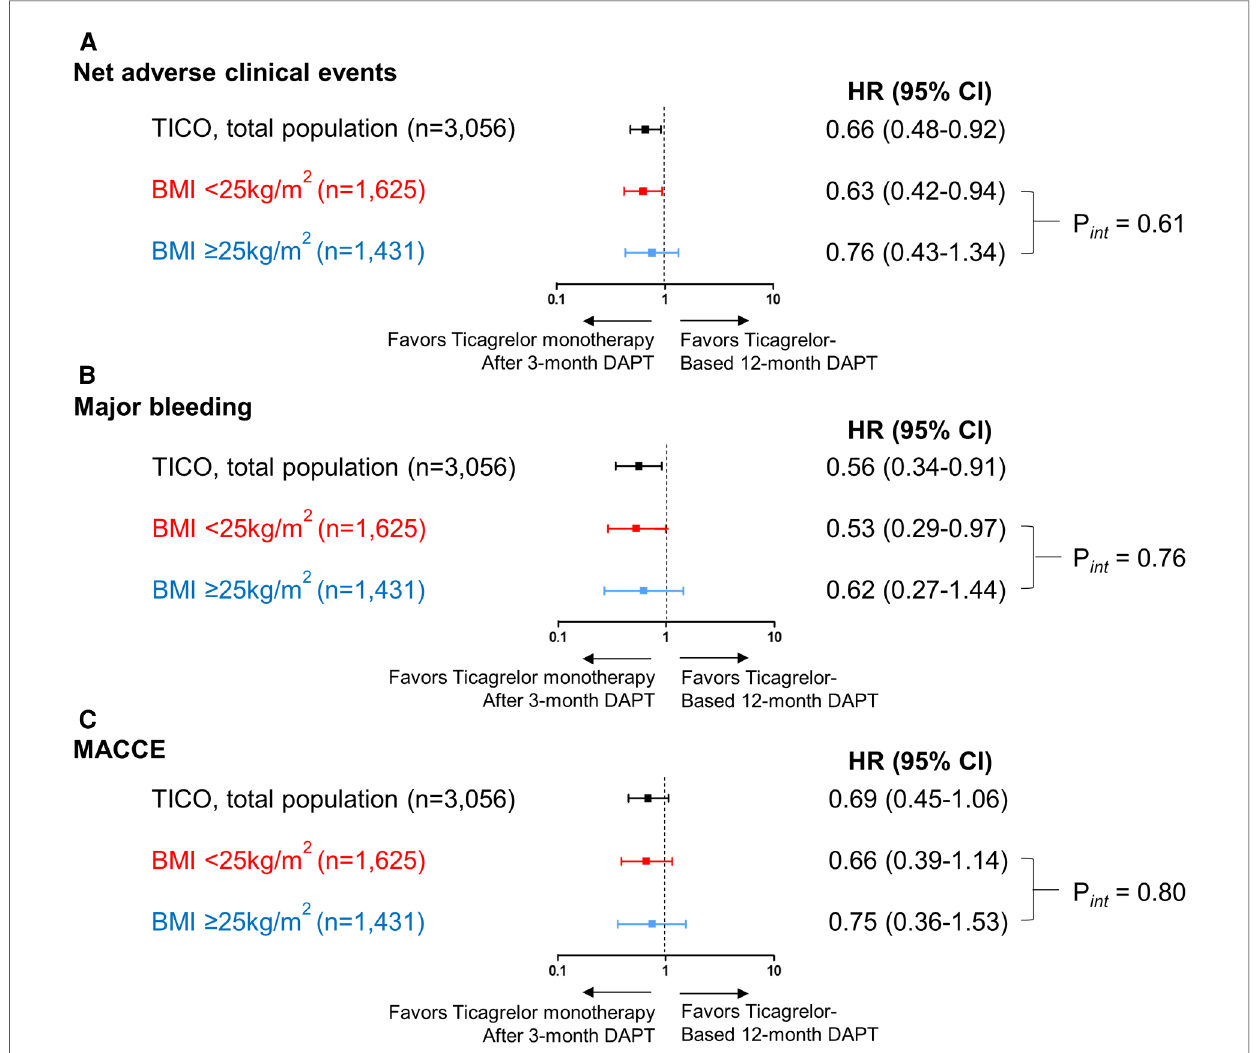
FIGURE 3 Risk for the primary outcome, major bleeding and MACCE according to the pre-speci fi ed BMI subgroups and antiplatelet strategies. Risk for ( A ) net clinical adverse events, ( B ) major bleeding and ( C ) MACCE according to the pre-speci fi ed BMI subgroups (BMI <25 and ≥ 25 kg/m 2 ) and antiplatelet strategies. The squares indicate estimated hazard ratio, and the horizontal lines indicate 95% CI. P for interaction values were derived from Cox regression model. BMI, body mass index; CI, con fi dence interval; DAPT, dual antiplatelet therapy; HR, hazard ratio; MACCE, major adverse cardiac and cerebrovascular